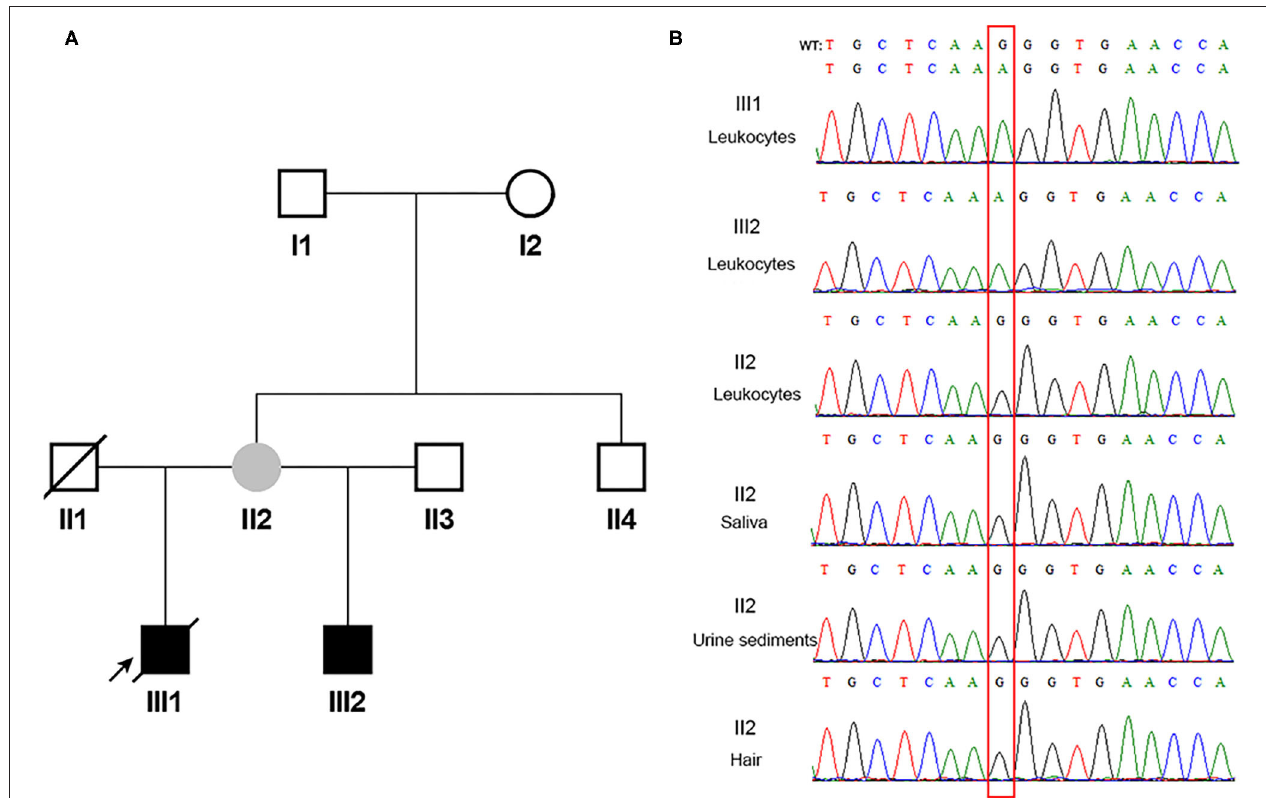
FIGURE 1 | The pedigree and direct sequencing results of multi-tissue in proband’s mother. (A) The black arrow indicates the proband. The filled black squares indicate the individuals presented with renal phenotypes, and the filled gray circle indicates the suspected mosaicism. (B) Direct sequencing results of multi-tissue. The red rectangle indicates c.2245-1 in COL4A5 . WT, wild type.